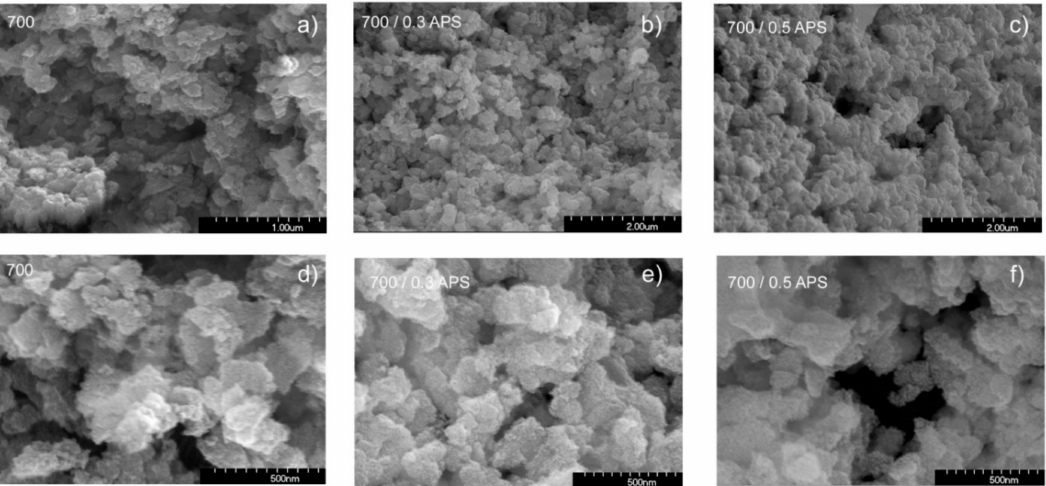
Figure 3. Scanning Electron Microscopy images of the particles pyrolyzed a 700 ◦ C and functionalized with the silane coupling agent γ -APS in solutions containing ( a ) and ( d ) 0% APS, ( b ) and ( e ) 0.3% APS and ( c ) and ( f ) 0.5% APS. Magnification 40 k for images ( a )–( c ) and 70 k for images ( d )–( f ).